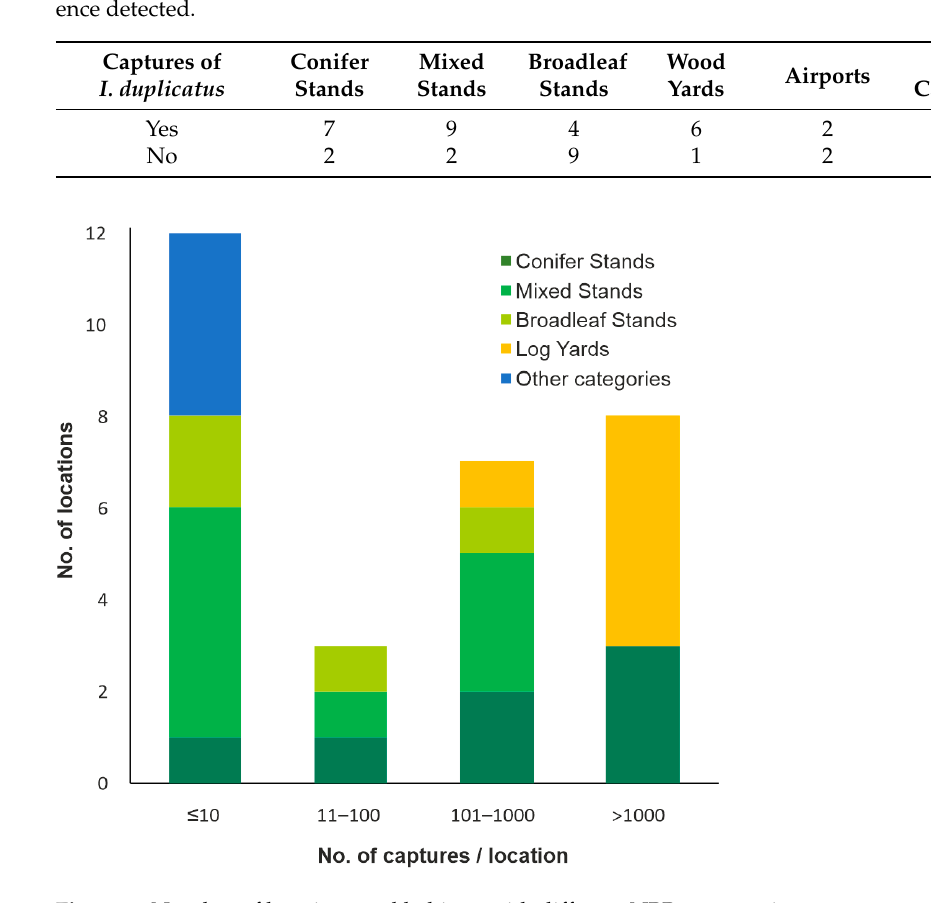
Figure 3. NBB capture variation according to tree stand composition.